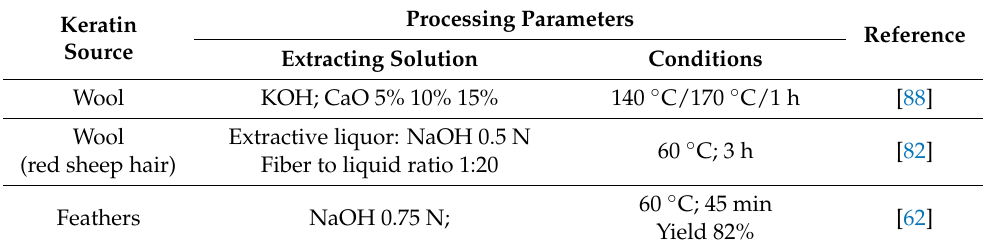
Table 5. Alkaline conditions and processing parameters used for the keratin extraction.